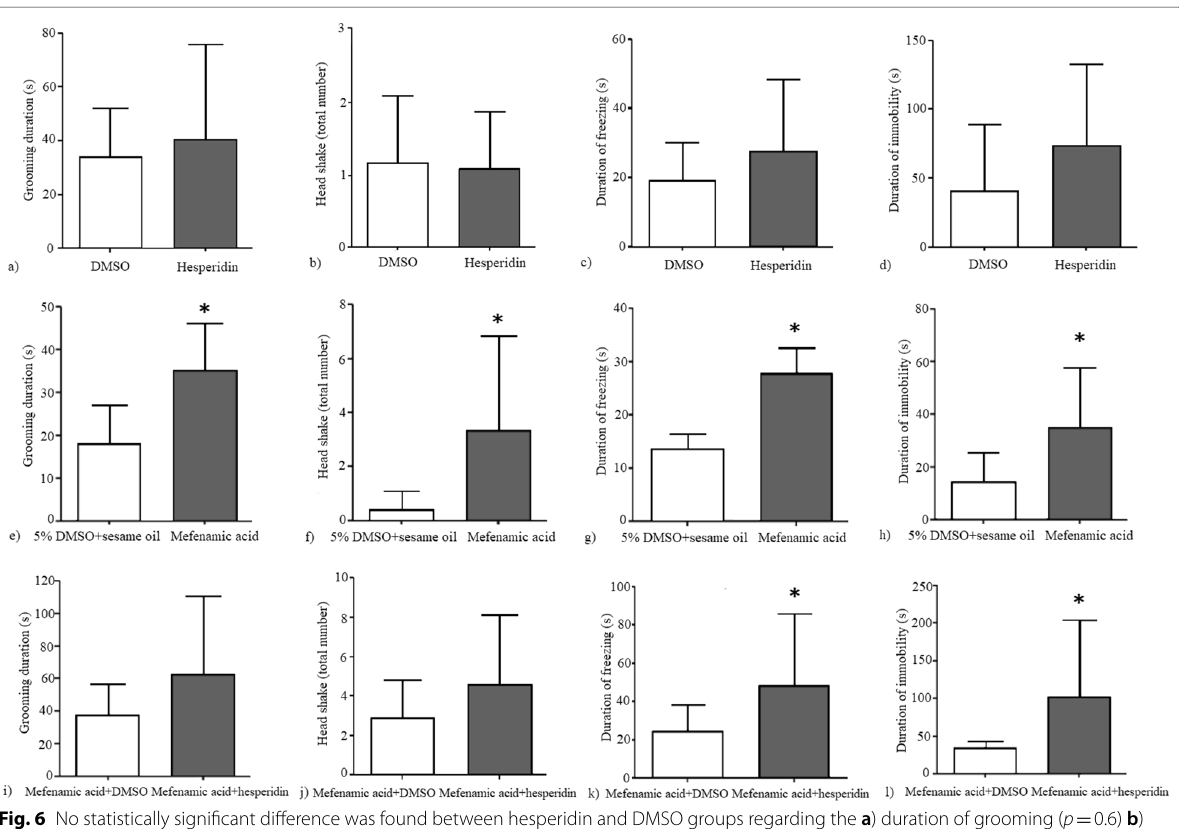
Fig. 6 No statistically significant difference was found between hesperidin and DMSO groups regarding the a ) duration of grooming ( p the number of head shakes ( p 0.82). c ) duration of freezing ( p 0.22) and d ) duration of immobility ( p 0.146). e ) Grooming duration, f ) number = = = of head shakes g ) duration of freezing, and h ) duration of immobility were higher in the chronic mefenamic acid group compared to its vehicle ( p 0.001, p 0.01, p 0.018 and p 0.01 respectively). i ) Grooming duration and j ) number of head shakes were similar between the chronic = = = = mefenamic acid plus hesperidin and chronic mefenamic acid plus DMSO groups ( p 0.113, p 0.17, respectively) while k ) duration of freezing = = ( p 0.048) and l ) duration of immobility ( p 0.03) were higher in chronic mefenamic acid plus hesperidin group. * p < 0.05 vs. = =